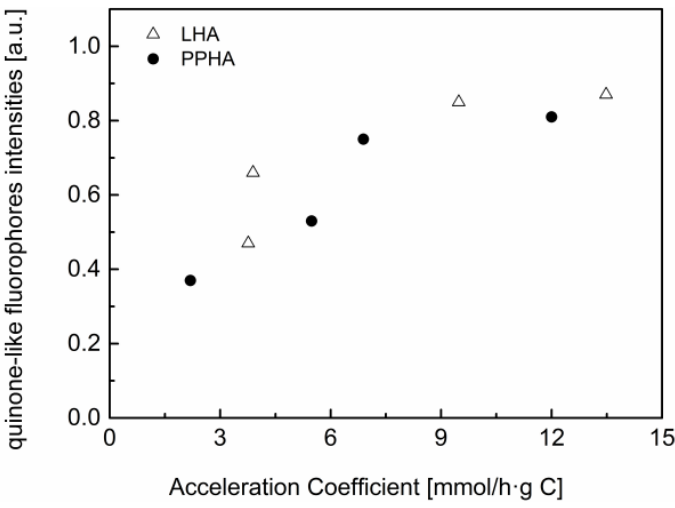
Figure 4. Relationship between the relative quinone-like fluorophores intensities of humic substances and their acceleration coefficients in the low TOC concentration range of 2.5 – 15 mg C/L.